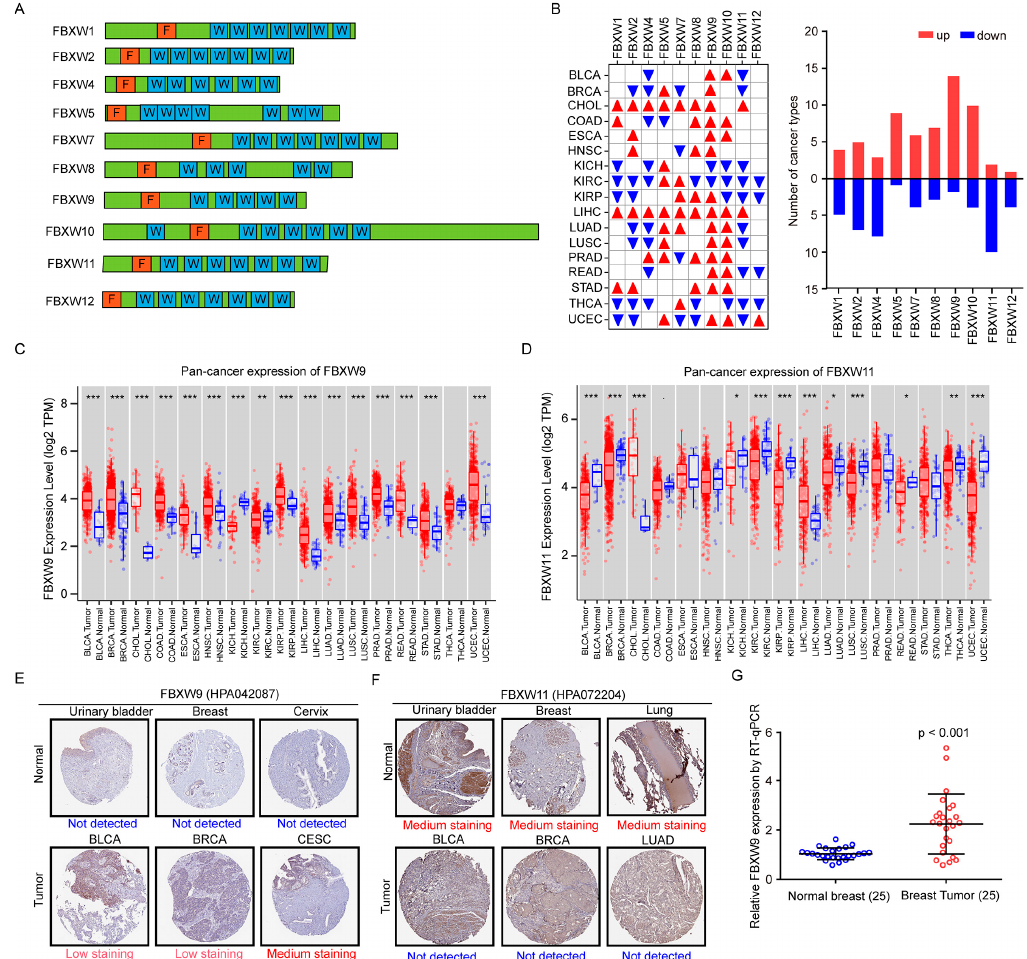
Figure 1. Analysis of FBXW expression in pan-cancer tissues and normal tissues. ( A ) Schematics of the architecture of FBXWs. F: F-box domain. W: WD40 domain. ( B ) The expression of mRNA levels of FBXWs was analyzed in 17 cancer types and normal tissues from the TCGA database. Red triangle: overexpressed. Blue triangle: downregulated. The number of cancer types with differentially expressed FBXWs was counted and summarized. ( C ) The expression of FBXW9 in 17 cancer types compared with normal tissues is presented in box plots. ( D ) The expression of FBXW11 in 17 cancer types compared with normal tissues is presented in box plots. ( E ) Representative images of immunohistochemistry (IHC) data of FBXW9 staining in tumors and normal tissues from the Human Protein Atlas (HPA) database. ( F ) Representative images of IHC data of FBXW11 staining in tumors and normal tissues from the Human Protein Atlas (HPA) database. ( G ) RT-qPCR detection of FBXW9 mRNA expression in 25 pairs of tumors and normal tissues from patients diagnosed with breast cancer. *, p < 0.05; **, p < 0.01; ***, p < 0.001.